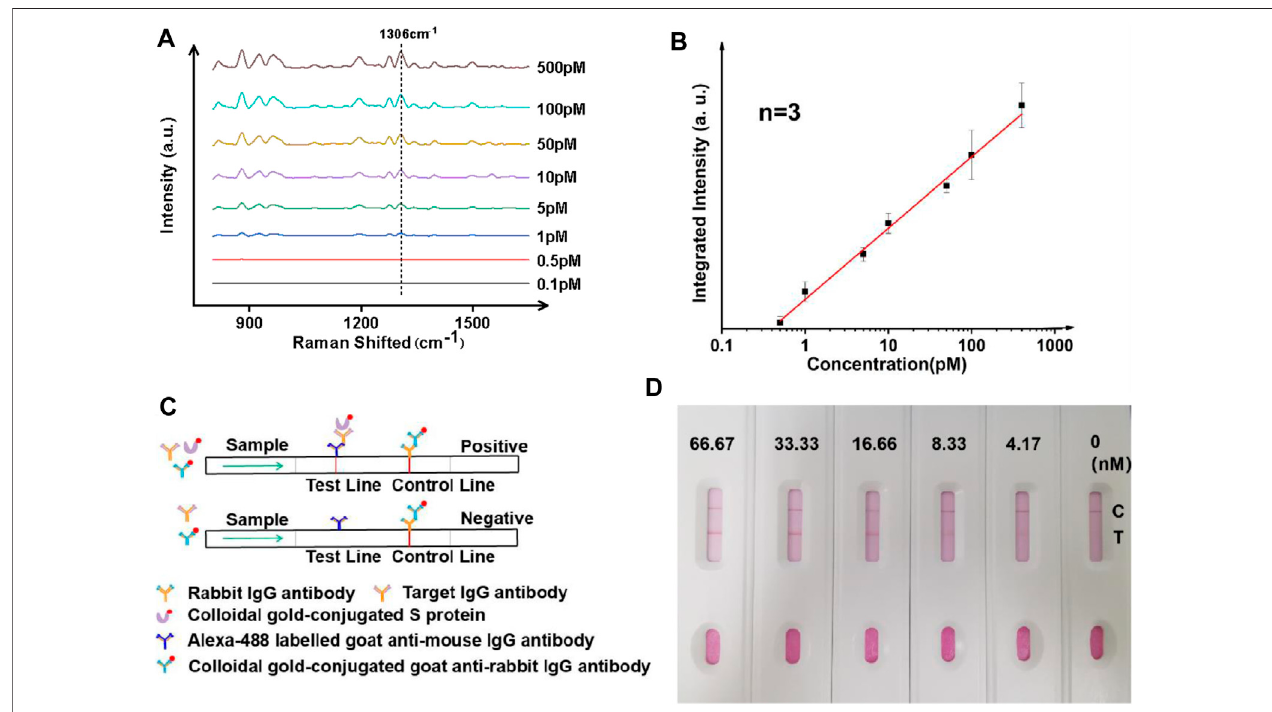
FIGURE 3 | Ultrasensitive analysis of IgG antibodies using whole blood mimic and comparison to a paper-based lateral fl ow assay. (A) Typical SERS spectra with targetsofdifferent concentrations. (B) Linearity showingincreasing intensity ofthe signaturepeakatvariedconcentrationsoftheanalyte.Three samples wereusedfor each measurement. (C) Principle and (D) results of the paper-based lateral fl ow sensor, showing a LoD of between 4 and 8 nM in a typical paper-based lateral fl ow assay.